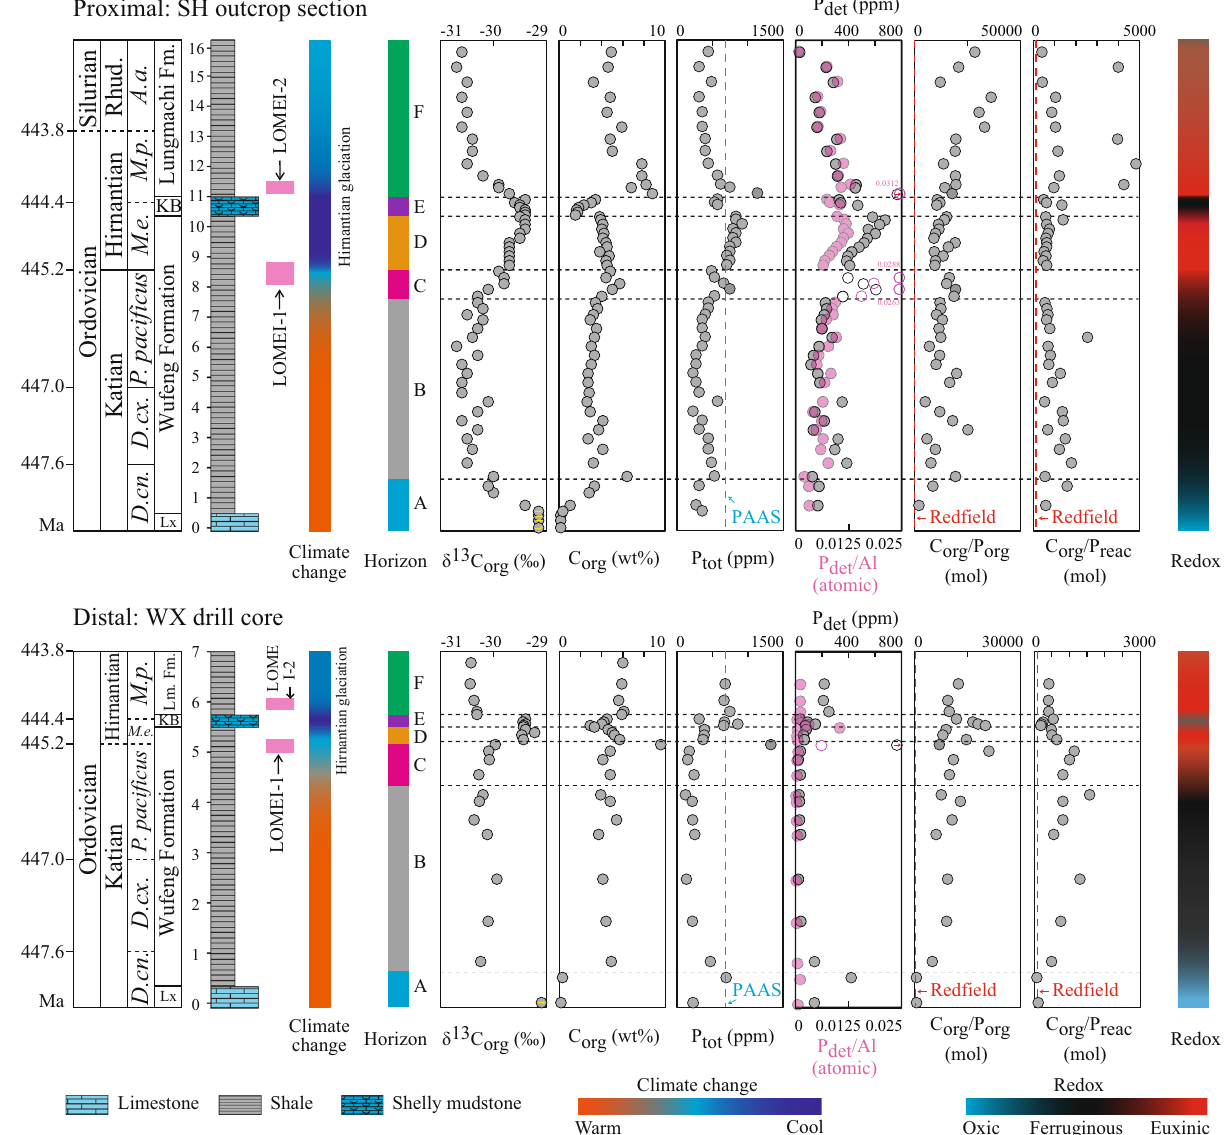
Fig. 1 Geochemical and isotopic data for the proximal Shuanghe (SH) outcrop section and the distal Wuxi (WX) drill core from the Yangtze Shelf Sea, South China. Data for δ 13 C org , C org , P tot , climate change and redox conditions for the SH section are modi fi ed from ref. 4 . See Supplementary Information for the climate and redox characterization of the WX drill core. Six stratigraphic horizons (A to F) are distinguished based on these water column redox dynamics. The two extinction intervals of the LOME are denoted as LOMEI-1 and LOMEI-2 2, 4 . Open circles represent samples with anomalous P det contents or P det /Al ratios, which likely represent post-depositional transfer of P aut to P det (see main text and Supplementary Information for details). While this affects C org /P reac ratios (and hence the ratios for these samples are discluded from consideration), it does not affect C org /P org ratios. Dashed blue line represents the average P tot concentration for Post-Archean Australian Shale (PAAS). A molar C/P ratio of 106:1 denotes the Red fi eld ratio (red dashed line). The ages of graptolite zones are from ref. 1 . Graptolite zones: D. cn . Dicellograptus complanatus , D. cx . Dicellograptus complexus , P. paci fi cus Paraorthograptus paci fi cus, M. e . Metabolograptus extraordinarius, M. p . Metabolograptus persculptus, A. a . Akidograptus ascensus . Rhud. Rhuddanian, Lx Linxiang Formation, KB Kuangyinchiao Bed, Lm.Fm. Lungmachi